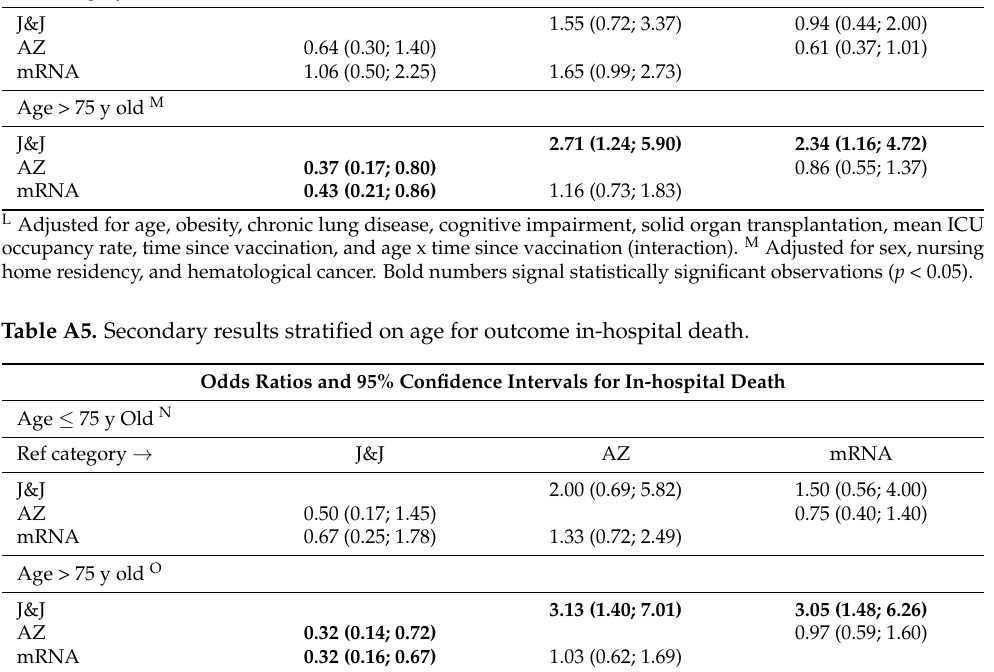
N Adjusted for age, nursing home residency, chronic lung disease, chronic renal disease, and mean ICU occupancy rate. O Adjusted for sex, nursing home residency, chronic lung disease, chronic liver disease, and hematological cancer. Bold numbers signal statistically significant observations ( p <